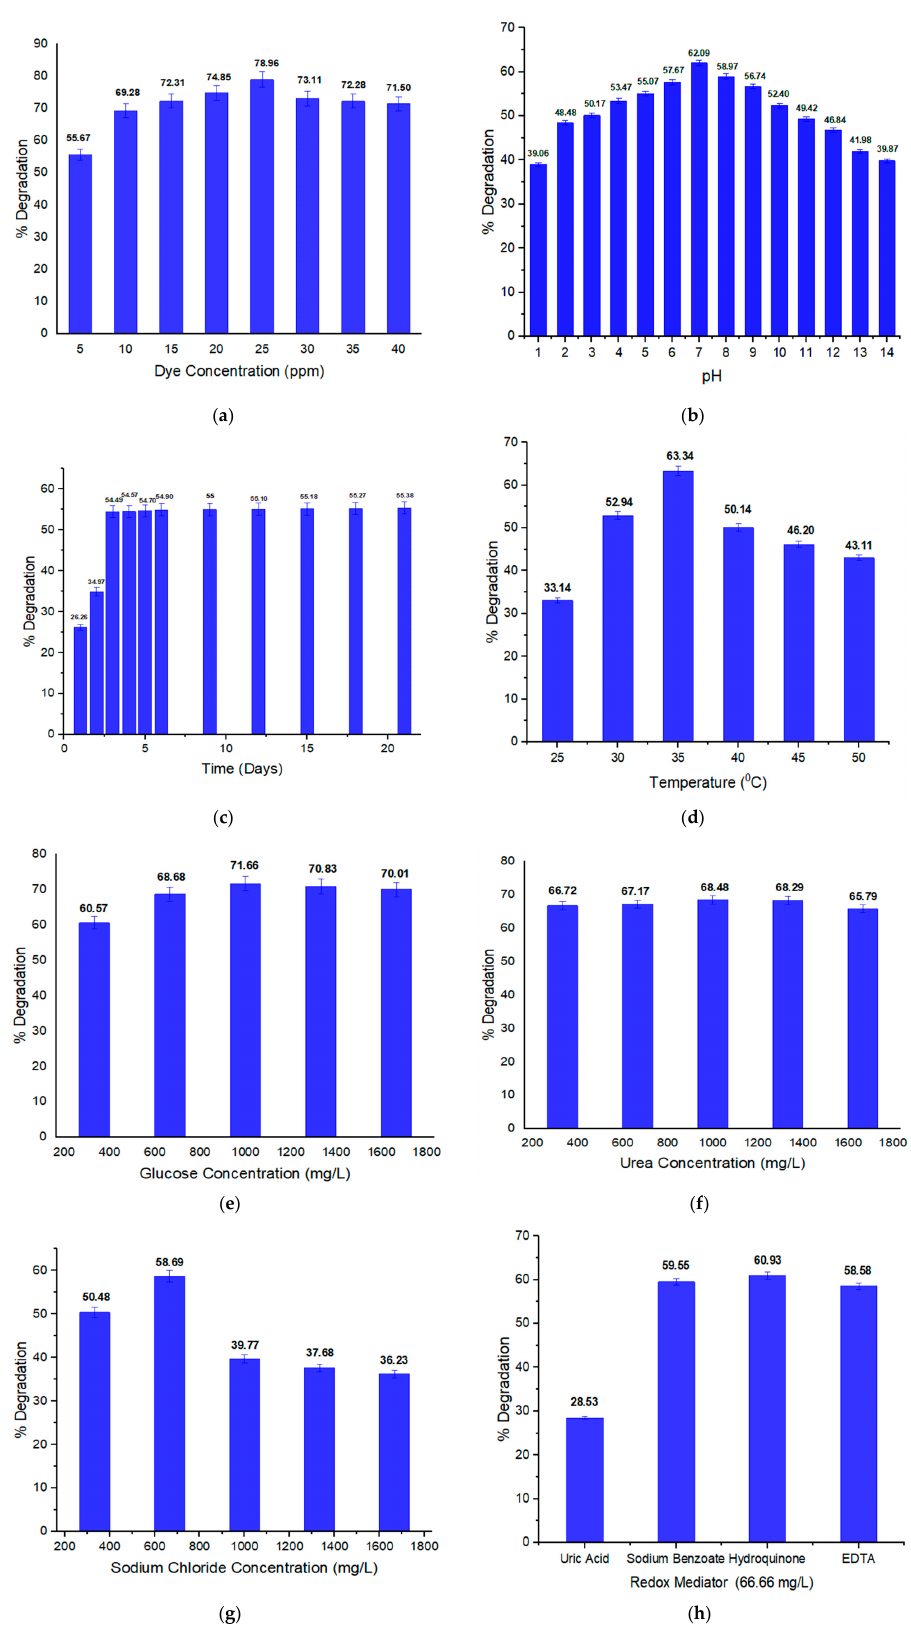
Figure 2. Effects of ( a ) dye concentration, ( b ) pH, ( c ) incubation duration (time), ( d ) temperature, ( e ) glucose concentration, ( f ) urea concentration, ( g ) sodium chloride concentration and ( h ) redox mediators on degradation of orange II.